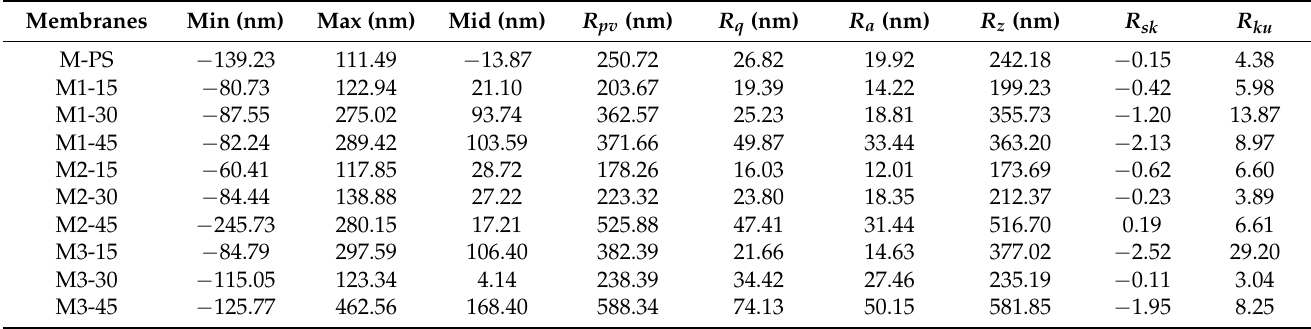
Figure 8. 3D AMF pictures of membrane surface roughness of all formulated membranes. Table 2. The quantitative measurements of the image statistics from selected parts of the membranes represent the various parameters related to the surface